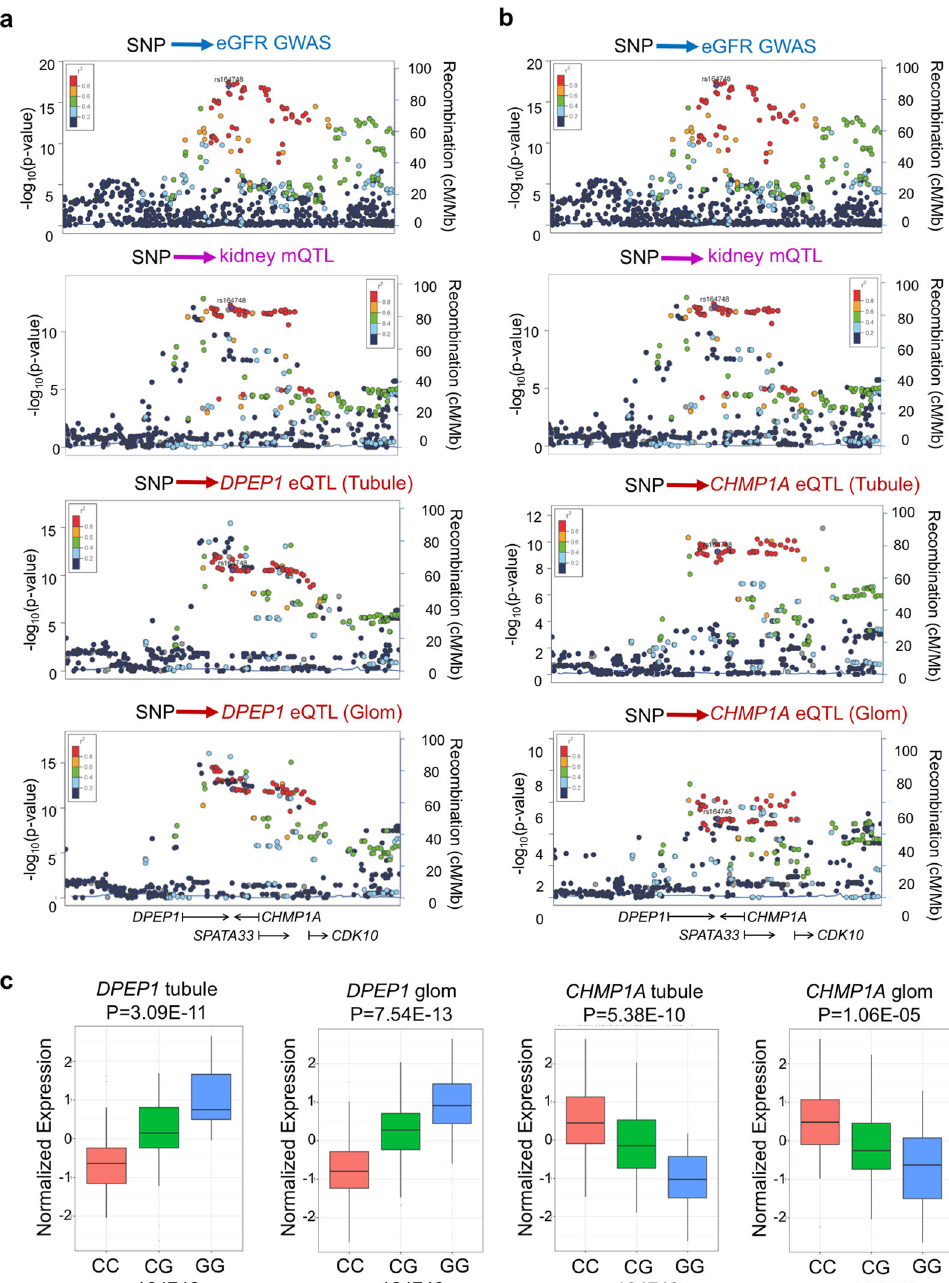
Fig. 1 Shared genetic variants associated with kidney function, human kidney methylation, and DPEP1 / CHMP1A expression. a LocusZoom plots of eGFR GWAS, human kidney mQTL analysis (genotype-methylation, n = 188), eQTLs (genotype-expression of DPEP1 ) in kidney compartments (tubule n = 121 or glomerulus n = 119). b LocusZoom plots of eGFR GWAS, human kidney mQTL analysis (genotype-methylation, n = 188), eQTLs (genotype-expression of CHMP1A ) in kidney compartments (tubule n = 121 or glomerulus n = 119). The x-axis indicates the genomic location on chromosome 16. The arrow indicates the transcriptional direction for speci fi c genes. Each dot represent one SNP. The dots are colored according to their correlation to the index SNP (rs164748). The red dots indicates strong correlation ( r 2 > 0.8) (LD) with the index SNP. The left y-axis indicates − log 10 ( P value). The right y-axis indicates recombination rate (cM/Mb). c Genotype (rs164748) and gene expression ( DPEP1 and CHMP1A ) association in human tubules ( n = 121) and glomeruli ( n = 119) in the Susztak lab database 40 . The effect size estimate (Beta) and standard error (SE) are as below: DPEP1 tubule Beta = 0.811 and SE = 0.11; DPEP1 glom Beta = 0.889 and SE = 0.11; CHMP1A tubule Beta = − 0.766 and SE = 0.113; CHMP1A glom Beta = − 0.587 and SE = 0.127. Centerlines show the medians; box limits indicate the 25th and 75th percentiles; whiskers extend to the 5th and 95th percentiles. P value was calculated as previously published 40 .